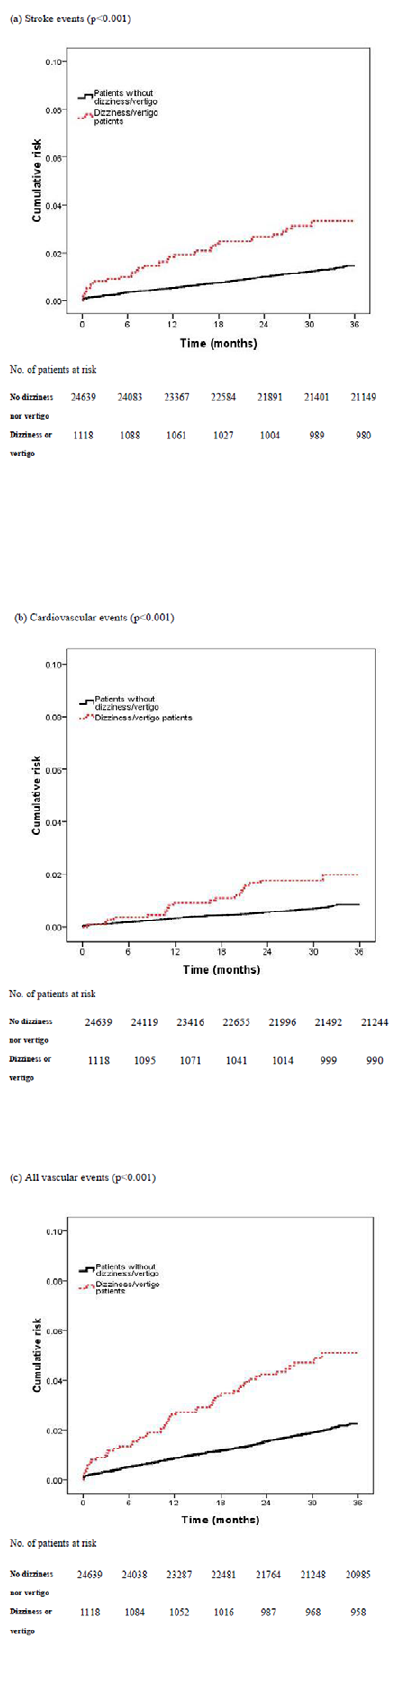
Figure 2. Cumulative risk of vascular events for the ER dizziness/ vertigo patients and patients without